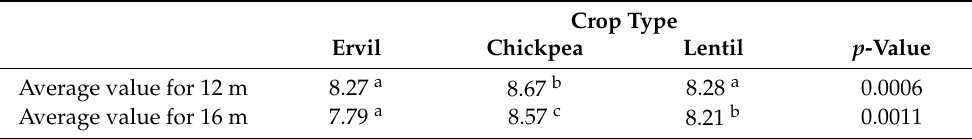
Table 4. Summary of ANOVA results with the mean values of selected areas.